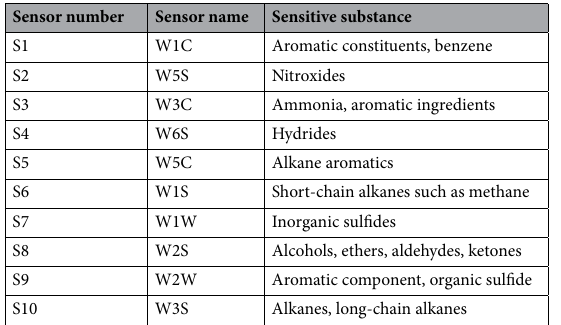
Table 1. Characteristics of MOS sensors utilized in PEN3 electronic